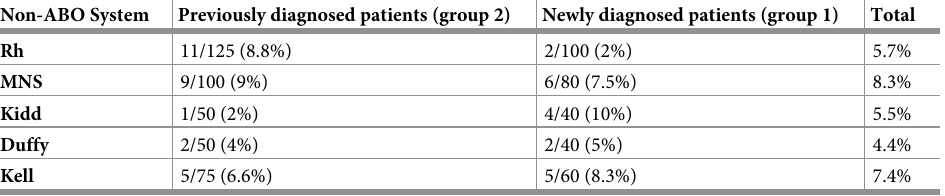
Table 4. Frequency of discrepancy of results between phenotyping and genotyping among each non-ABO blood group system in the studied MHS groups. Non-ABO System Previously diagnosed patients (group 2) Newly diagnosed patients (group 1) Total Rh 11/125 (8.8%) 2/100 (2%) 5.7% MNS 9/100 (9%) 6/80 (7.5%) 8.3% Kidd 1/50 (2%) 4/40 (10%) 5.5% Duffy 2/50 (4%) 2/40 (5%) 4.4% Kell 5/75 (6.6%) 5/60 (8.3%) 7.4% Data was expressed as frequency